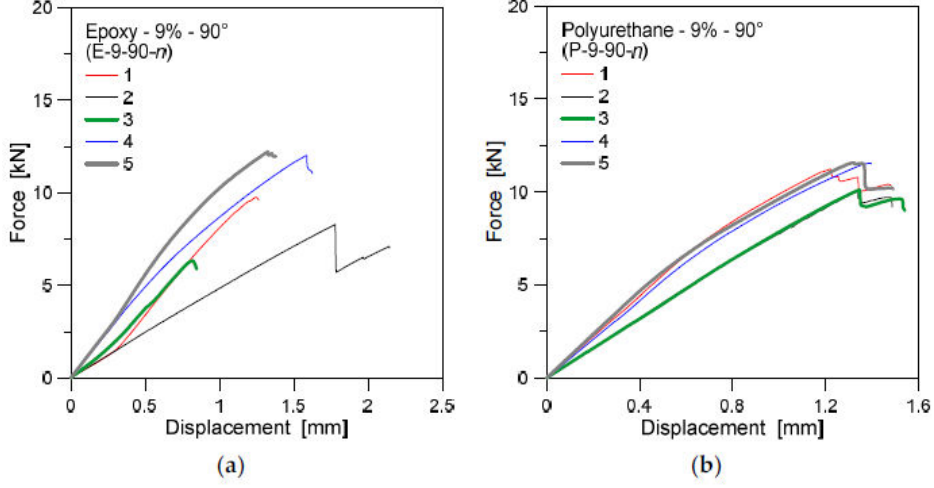
Figure 5. Experimental force–displacement results for specimens with ( a ) epoxy or ( b ) polyurethane glue, under 9% moisture and perpendicular rod-to-grain